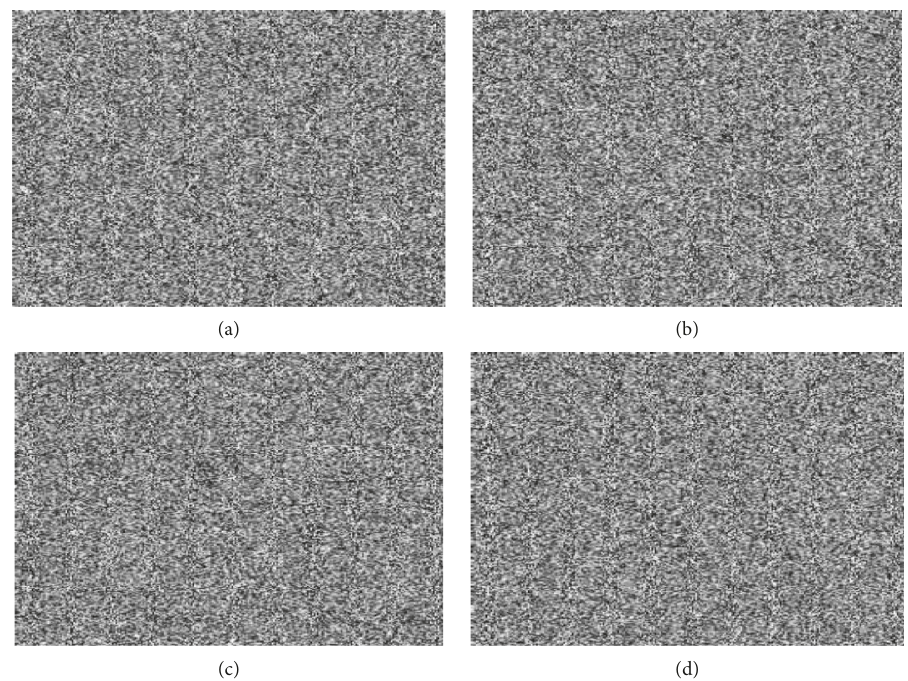
Figure 15: The recovering image under the worry secret key. (a) α � 0 . 00001, other parameters are unchanged. (b) β � 0 . 00001, other parameters are unchanged. (c) c � 0 . 00001, other parameters are unchanged. (d) δ � 0 . 00001, other parameters are unchanged.